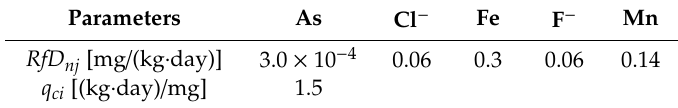
Table 8. Reference dosage values of non-carcinogens and cancer slope factor of carcinogen.